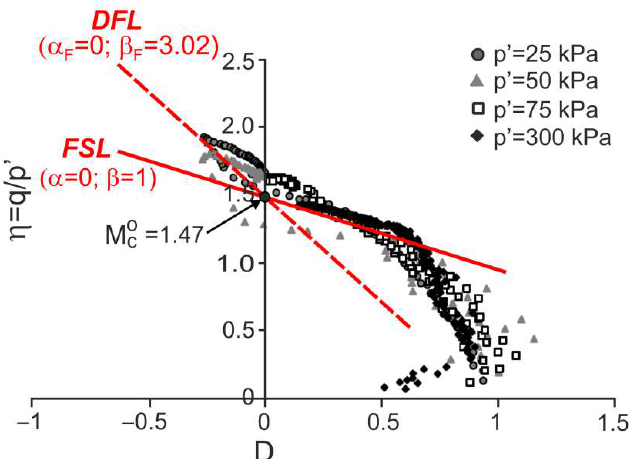
Figure 9. Stress ratio–dilatancy relationships for the drained triaxial compression of decomposed granitic residual soil (adapted from [7]). Reprinted from Publication Proceedings of the 15th Eu-